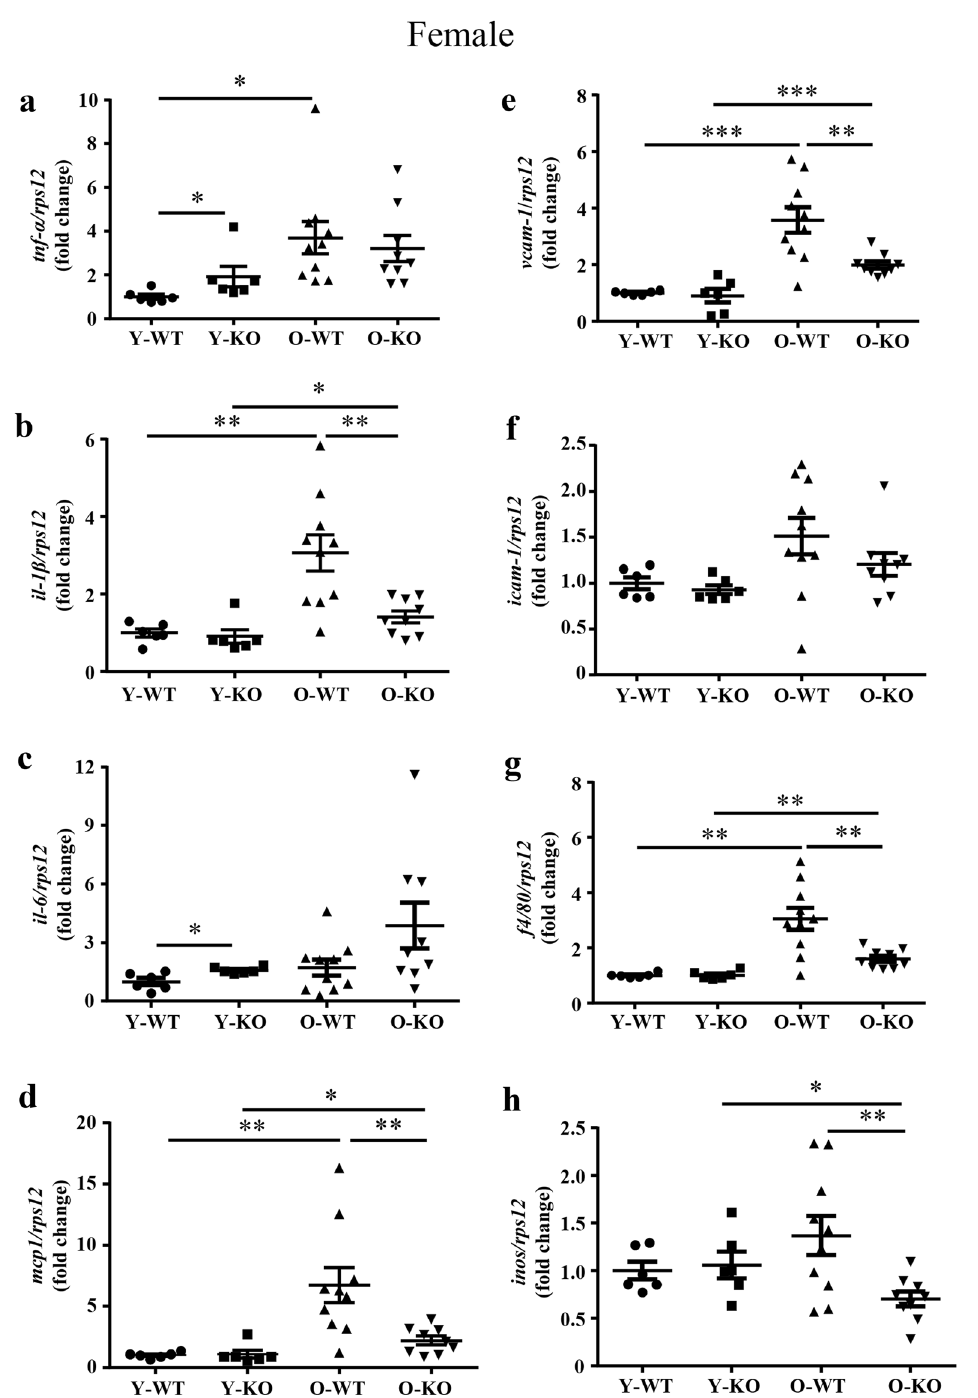
Fig. 2 Age-associated in fl ammation in the kidney was prevented in female arg-II − / − mice. a – h mRNA expression levels of tnf- α , il-1 β , il-6, mcp1,vcam-1, icam-1, f4/80 and inos in kidney were analyzed by qRT-PCR in female mice. rps12 served as the reference. Y-WT young WT,